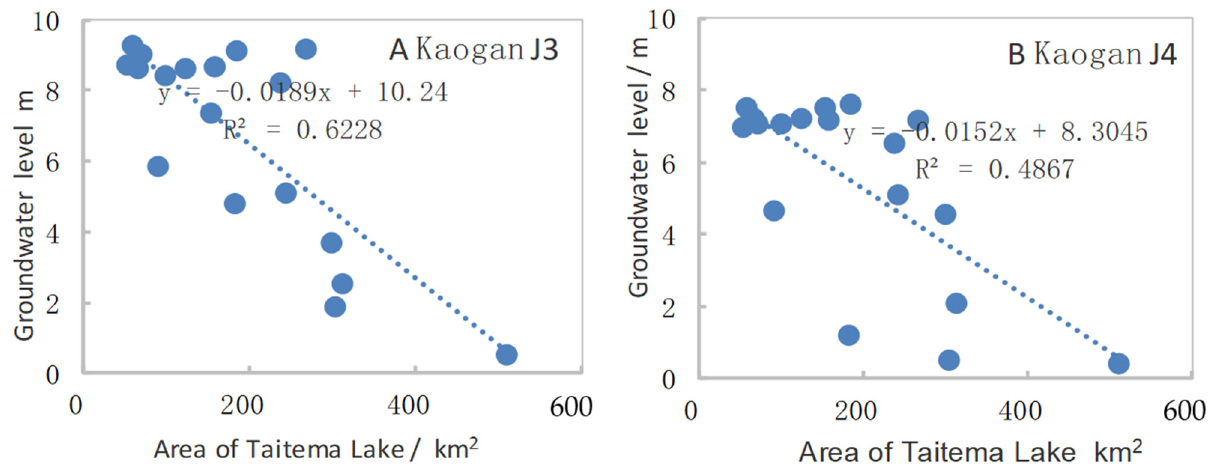
Figure 7. Relationship of groundwater of Kaogan section and area of Taitema Lake.